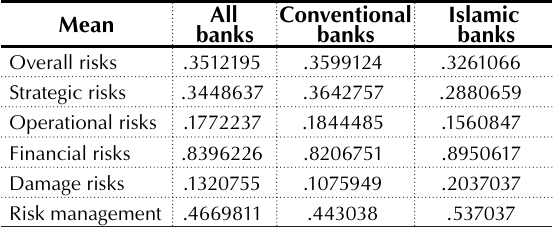
Table 11. Results of robust dynamic panel-data